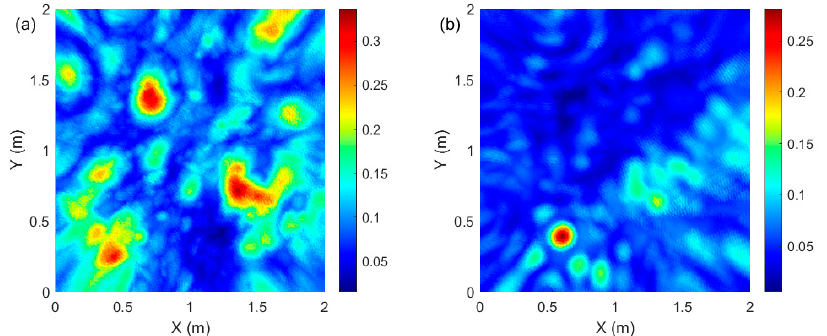
1 . ( a ) Without DNNs; ( b ) with DNNs.